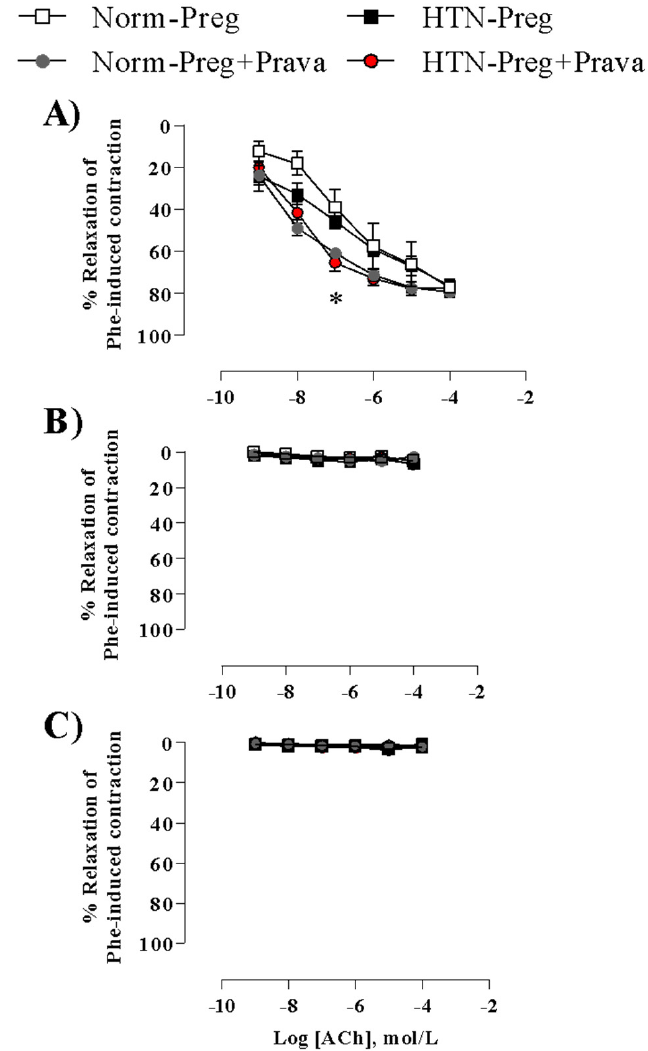
Figure 8. Acetylcholine (ACh)–induced relaxation (%) after precontraction with phenylephrine (Phe) in aortas with endothelium ( A ), aortas without endothelium ( B ), and aortas with endothelium and incubated with NO synthase inhibitor, L-NAME ( C ) of Norm-Preg, Norm-Preg + Prava, HTN-Preg, and HTN-Preg + Prava groups. Values represent mean ± SEM. * p < 0.05 vs. Norm-Preg and HTN-Preg.